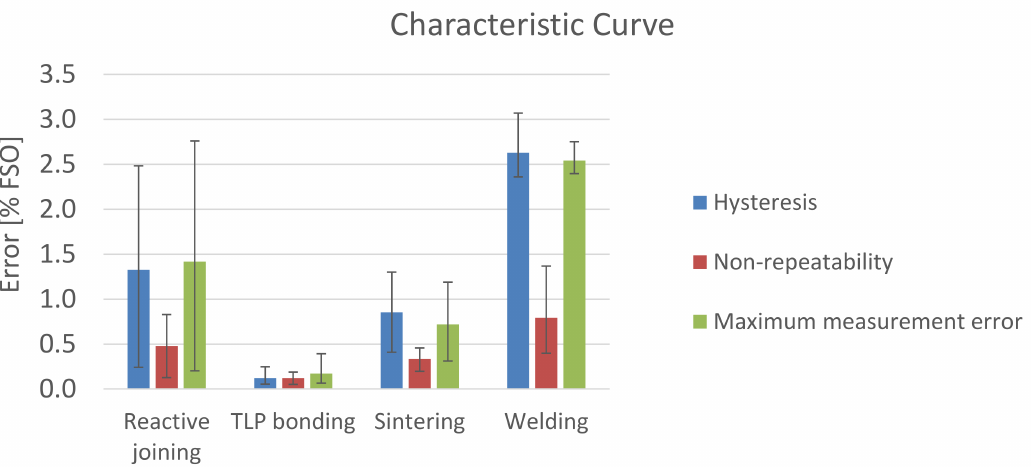
Figure 13. Results of the measurement of the characteristic